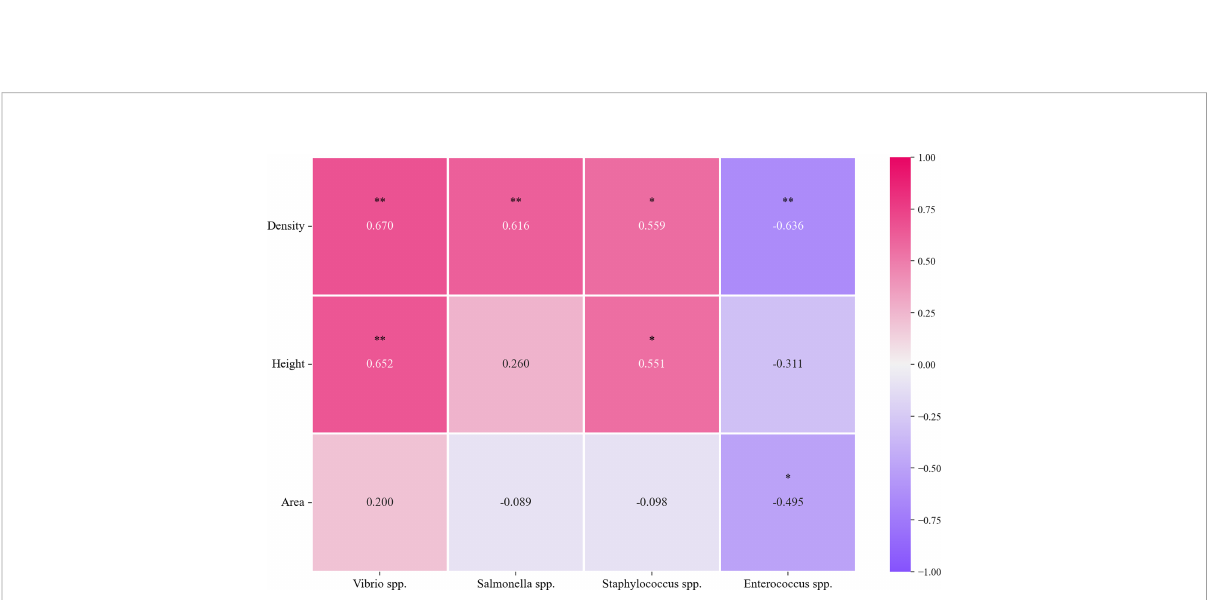
FIGURE 3 Relationship between four putative bacterial pathogens and three seagrass canopy metrics. Purple represents a negative correlation between variables, and red represents a positive correlation (*p<0.05, **p<0.01).